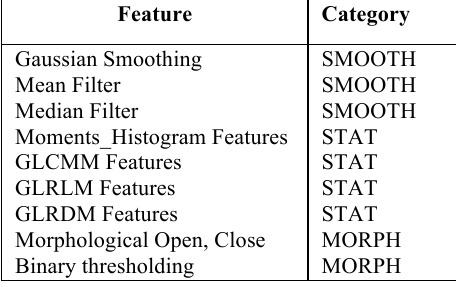
Table 2: Operators used to produce simple features which also form the building block for all tree-structured